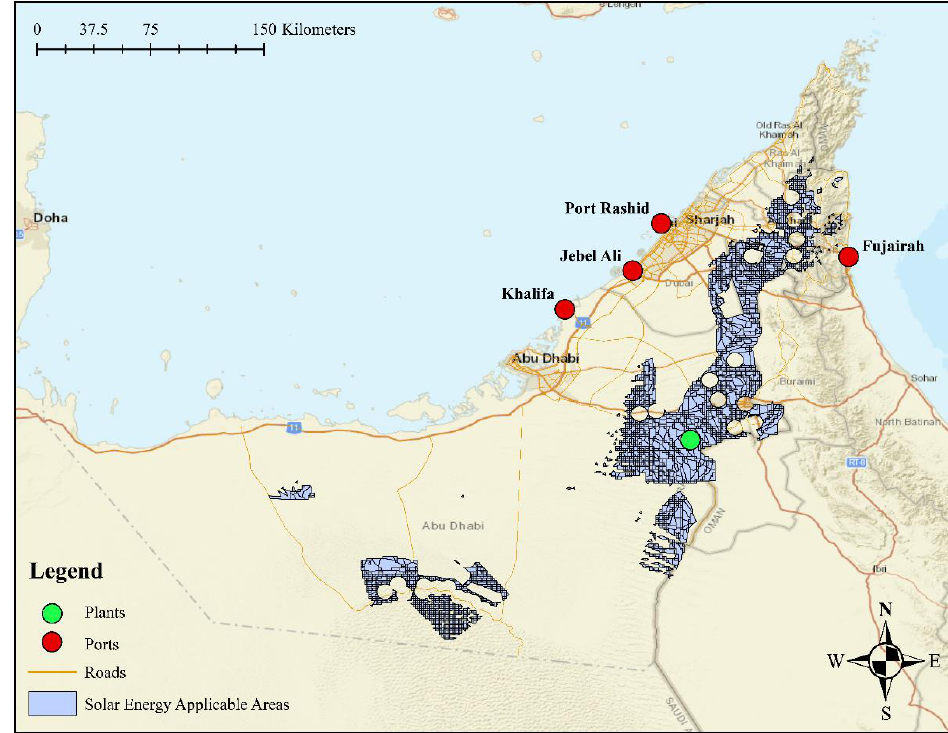
Figure 1. Solar energy applicable areas, suggested plant location and export ports in the UAE.